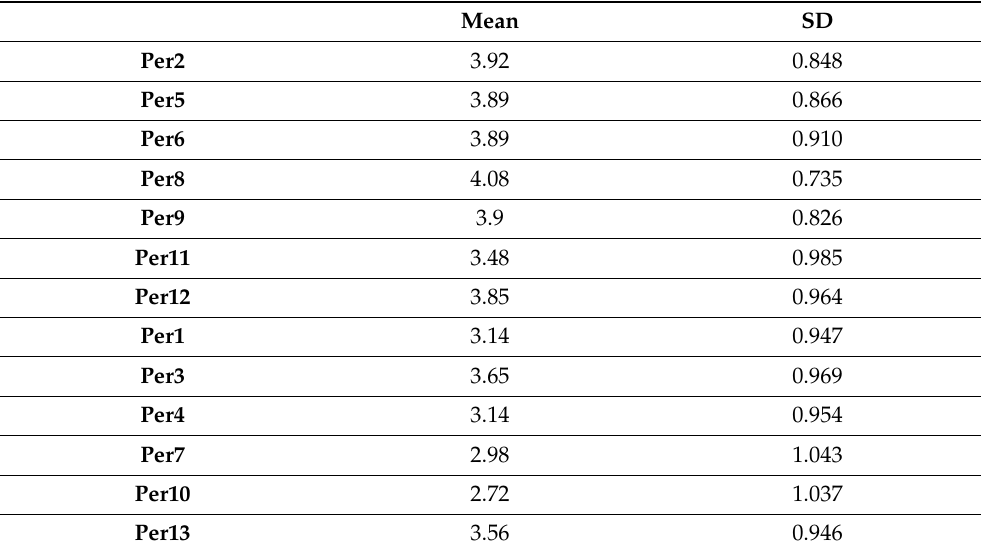
Table 2. Descriptive statistics for Motivational Persistence